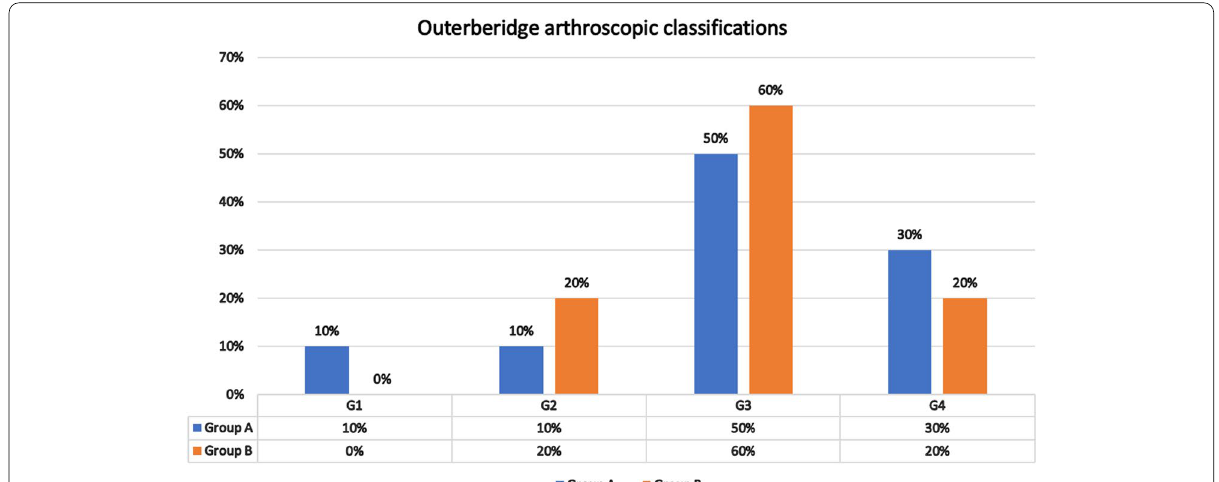
Fig. 12 Preoperative Outerbridge arthroscopic classifications of both groups